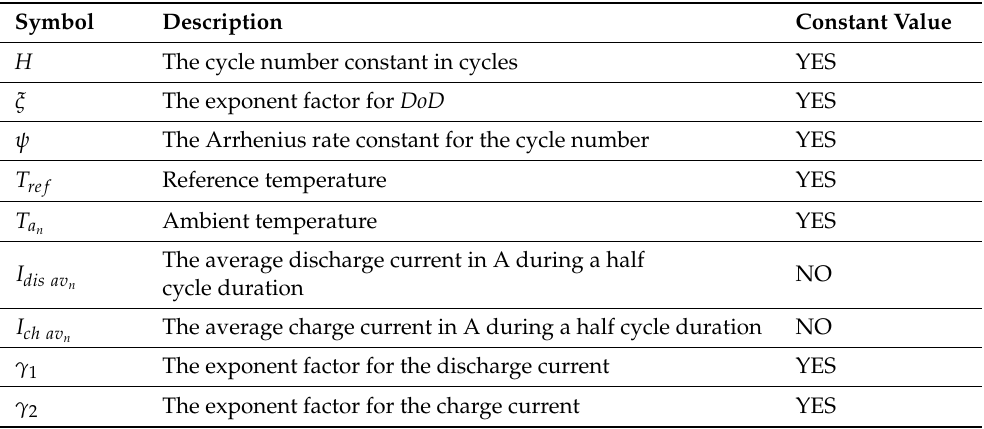
Table 2. Symbols used in Equation (5). Adapted from